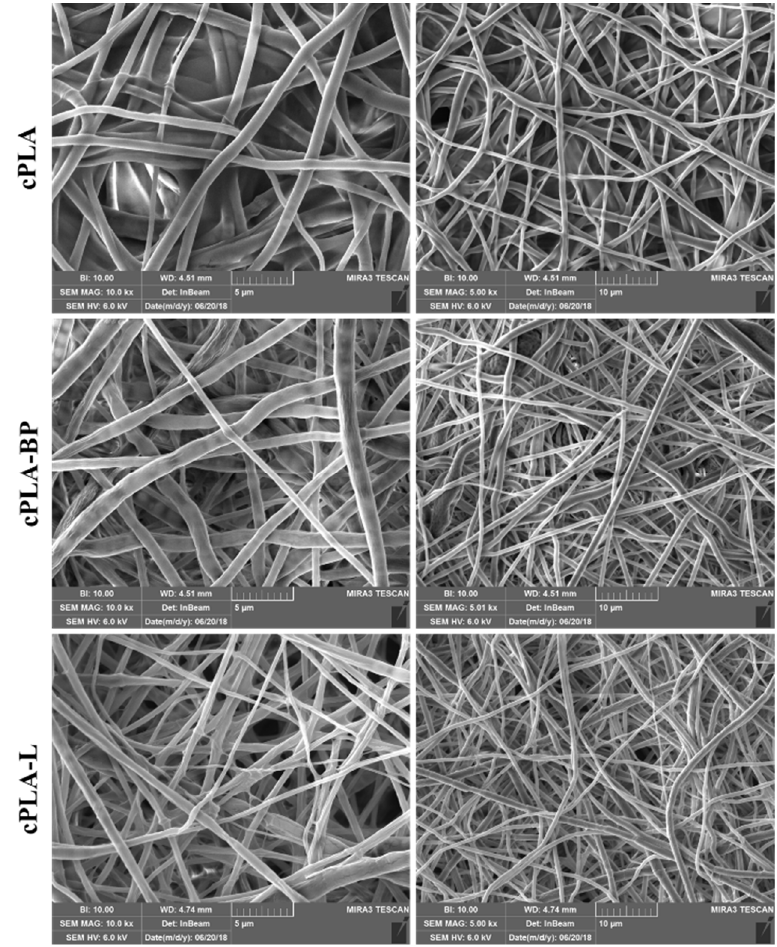
Figure 6. SEM micrographs, at different magnifications, of cPLA, cPLA-BP and cPLA-L fibres after immersion in water for 7 days. Scale bars: 5 μ m (left hand side), 10 μ m (right hand side).